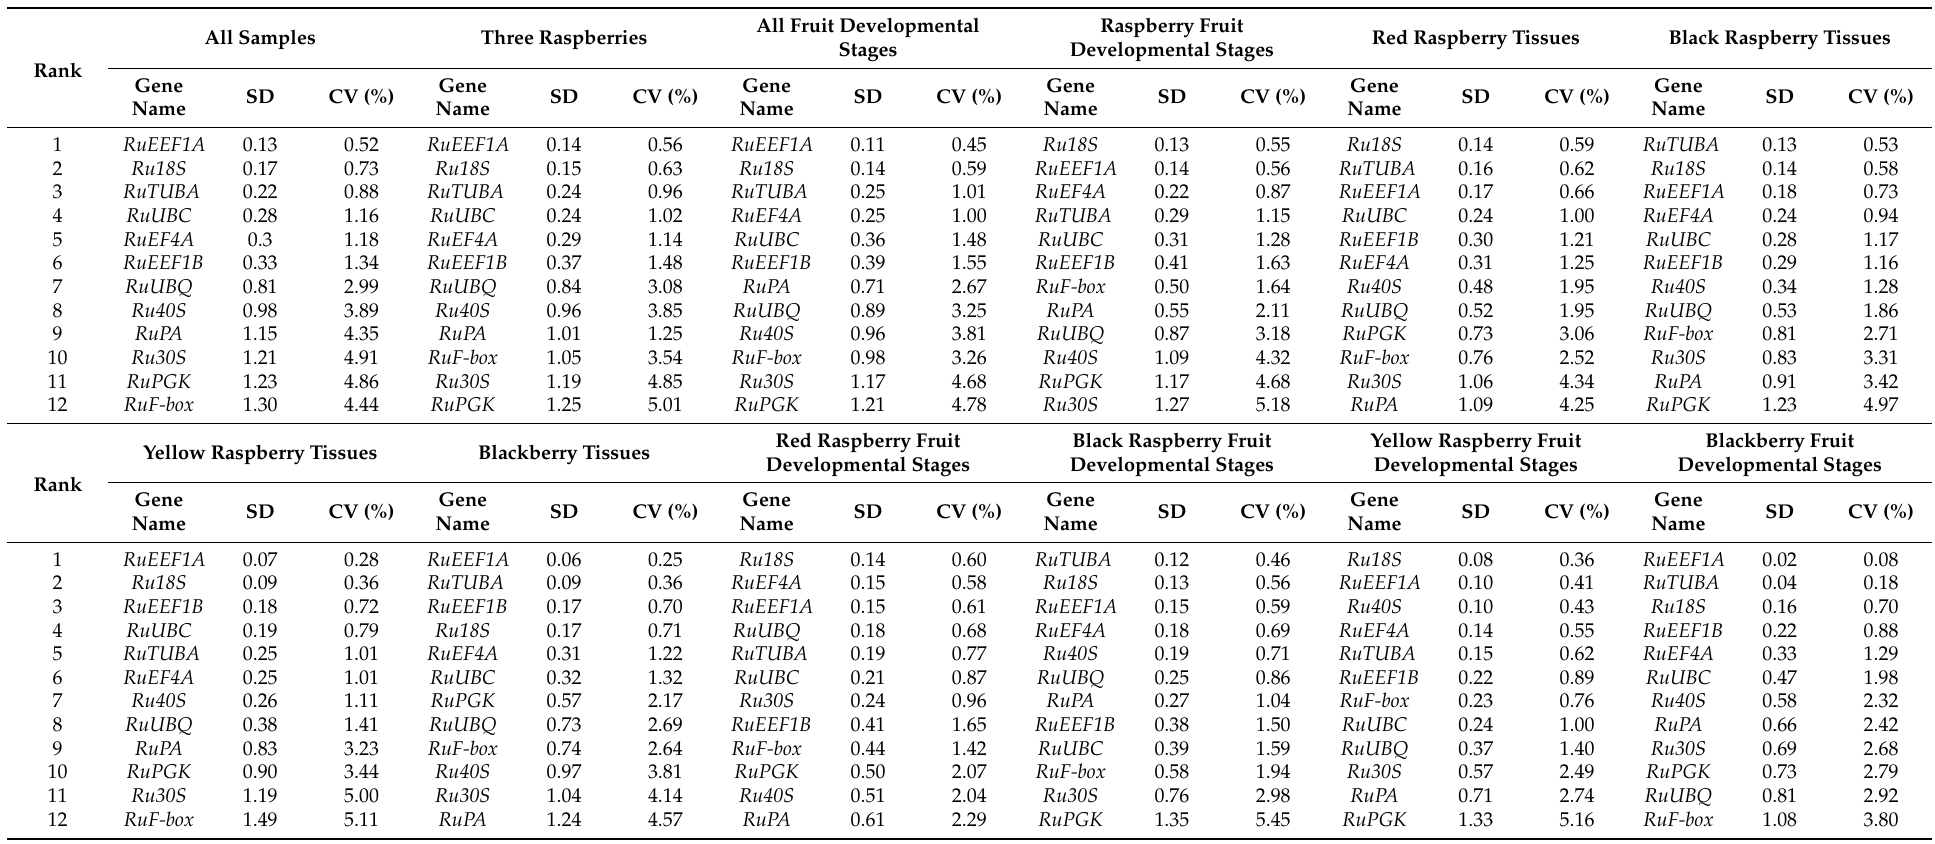
Table 2. Stability analysis of 12 candidate reference genes based on BestKeeper